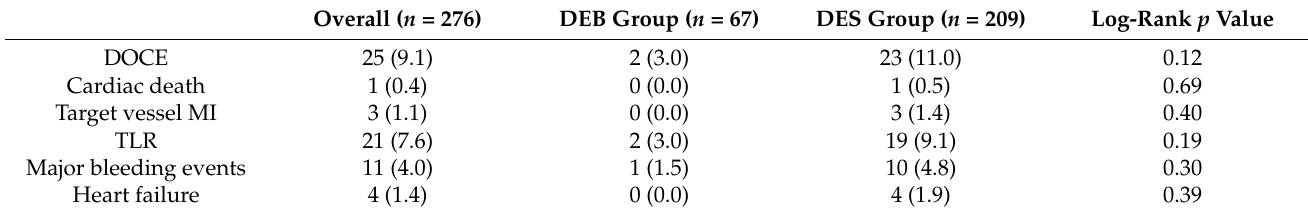
Table 3. Clinical outcomes after the index